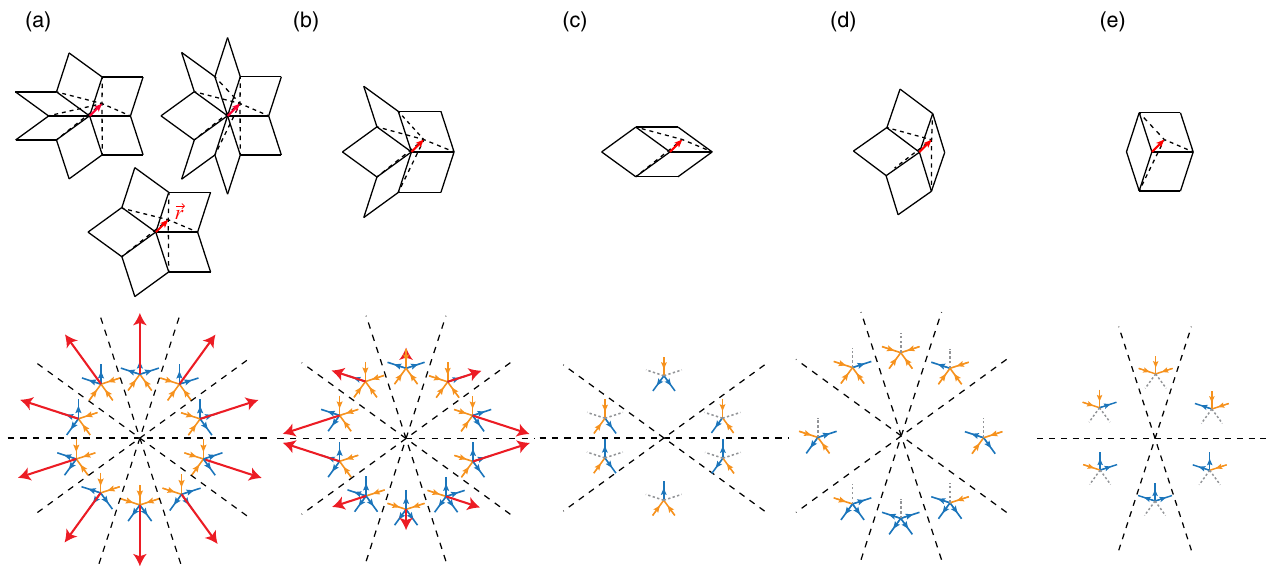
FIG. 5. A complete list of vertices (top row) in the Penrose tiling and their corresponding phase diagrams (bottom row) of the topological polarization as a result of their displacements. We use the same convention here as in Fig. 1. (a) z ¼ 5 , 6, 7 vertices which give the same phase diagram. These are the vertices we use in Fig. 1 to polarize the Penrose tiling. (b) Another type of z ¼ 5 vertices which give a different phase diagram. (c) – (e) z ¼ 3 , 4 vertices. For these vertices, the FMs remain bulk modes on strips of parallelograms along some directions because these strips do not pass through these z ¼ 3 , 4 vertices. We denote these directions using gray dashed lines in the phase